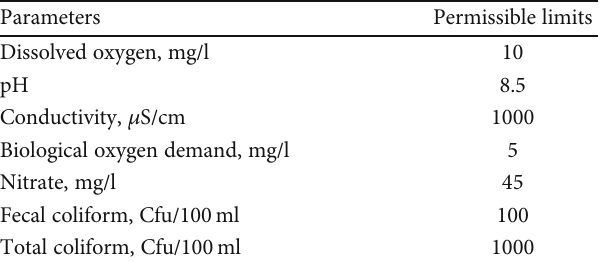
Table 1: Permissible limits of the parameters used in calculating WQI [43].